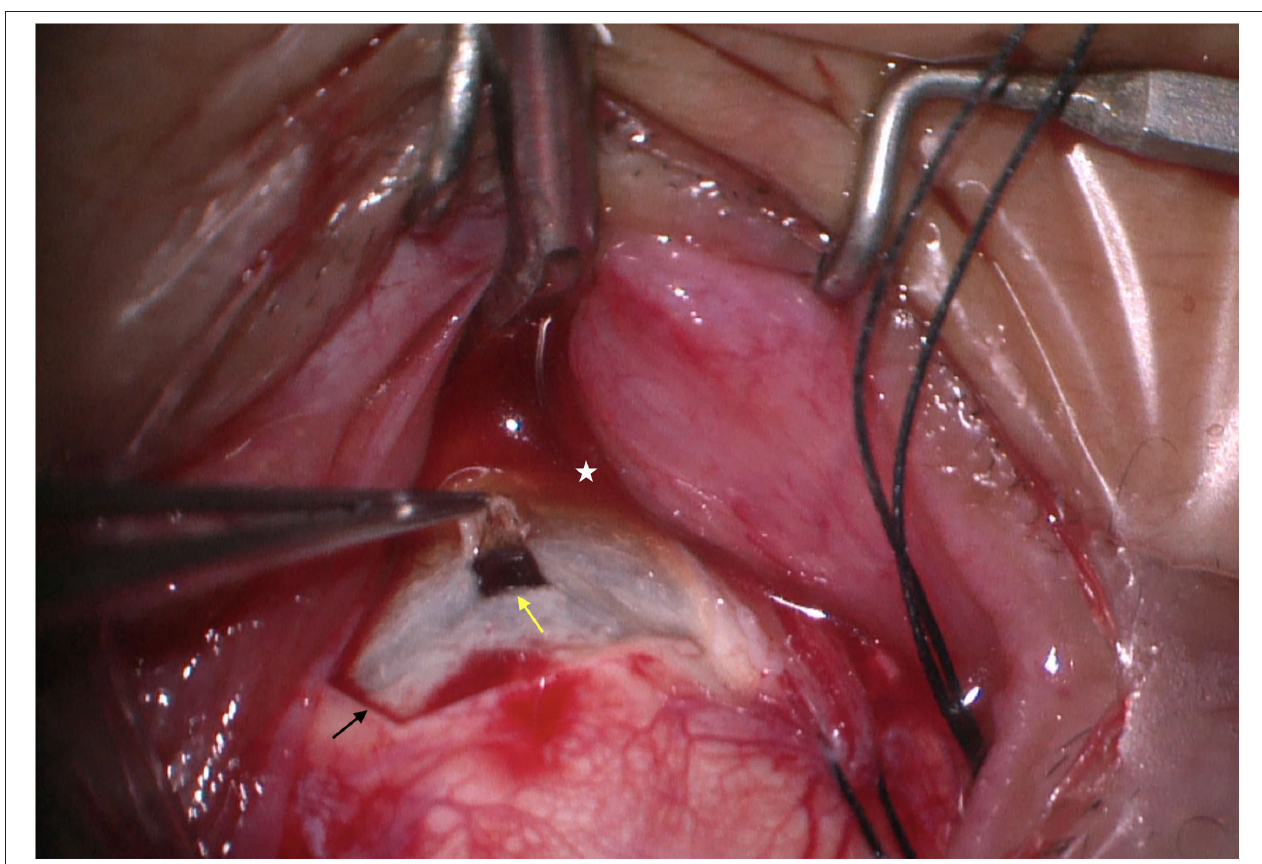
FIGURE 1 | Quadrantic lamellar-sclerectomy with sclerostomy. At the equator of each quadrant, we created a two-thirds thickness scleral incision measuring 6mm × 4mm (black arrow), on the center of each sclerectomy bed, the sclerostomy was excised in pieces measuring 2mm × 2mm (yellow arrow), and the choroid was exposed. The image was taken immediately after the sclerostomy was completed. Note that the choroid is exposed and abundant yellow serous suprachoroidal fluid was spontaneously released (white